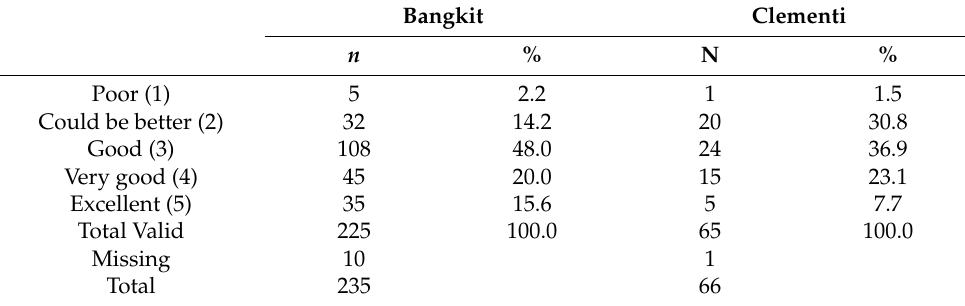
Table 5. Reported health condition.